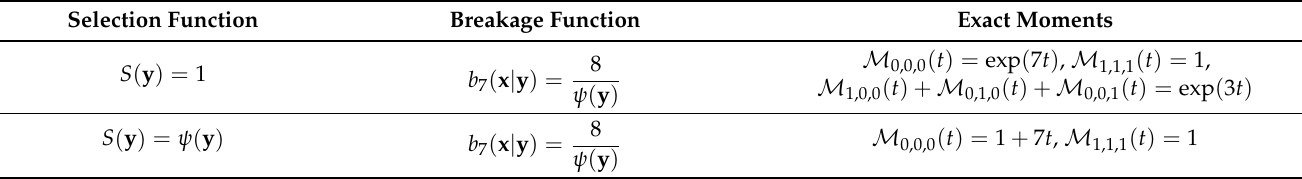
Table 15. Exact moment functions for S ( y ) = 1, S = ψ ( y ) and breakage function b 7